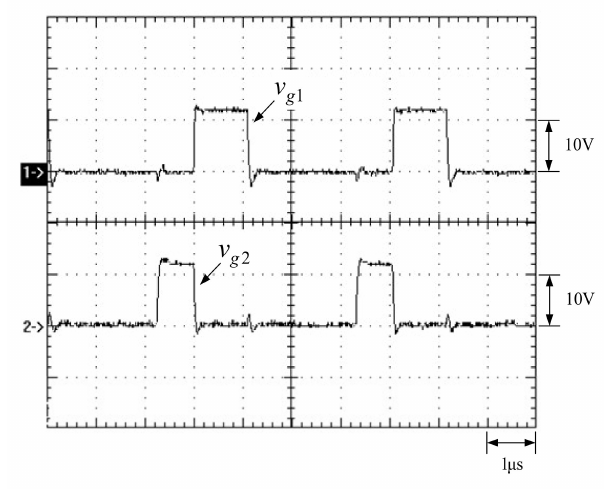
Figure 11. Gate driving signals for S 1 and S 2 : (1) v g 1 ; (2) v g 2 .